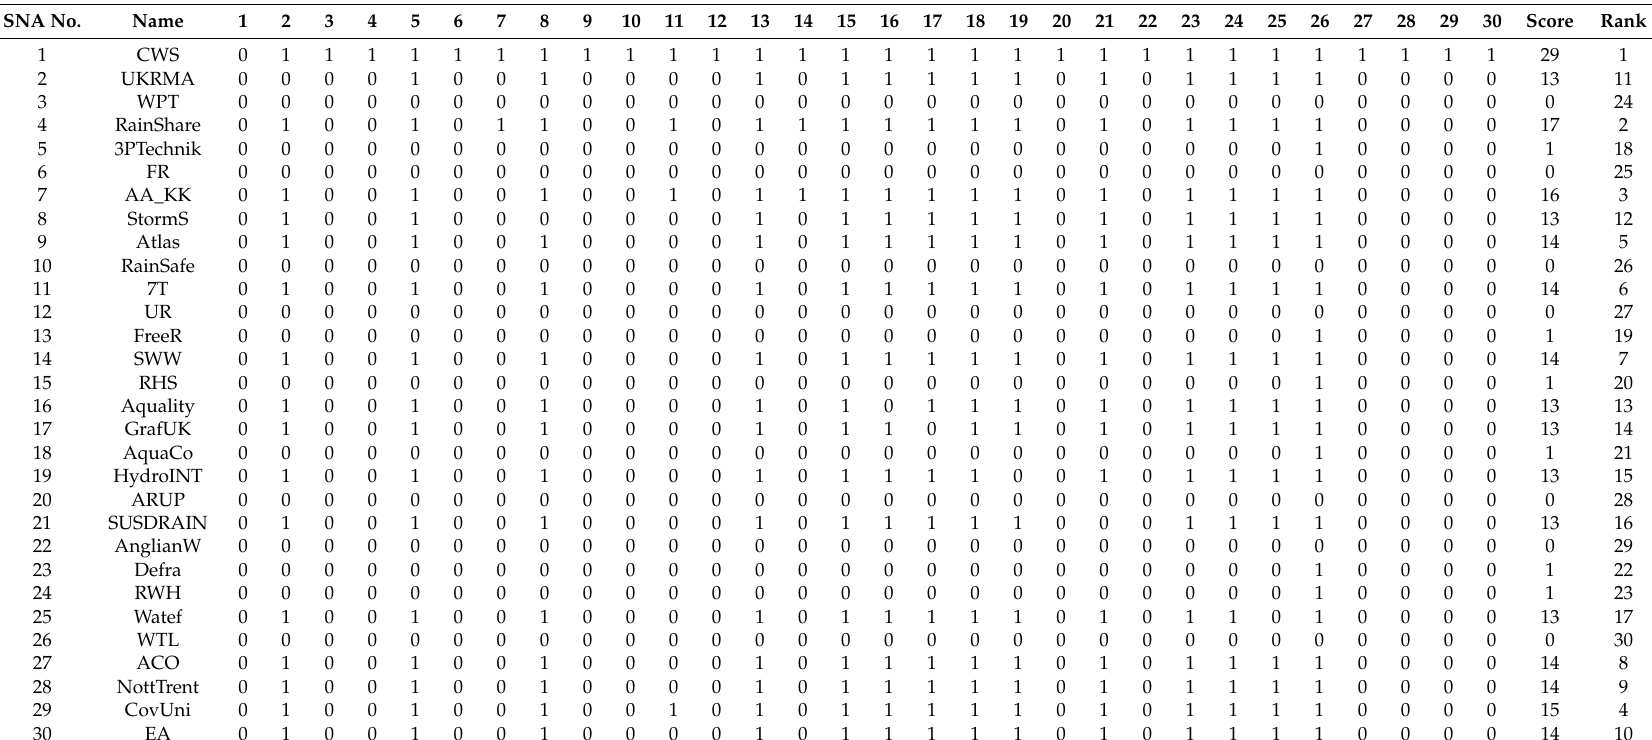
Table 2. Reachability matrix for infrastructure innovators and organisations in the rainwater harvesting network interaction model. SNA